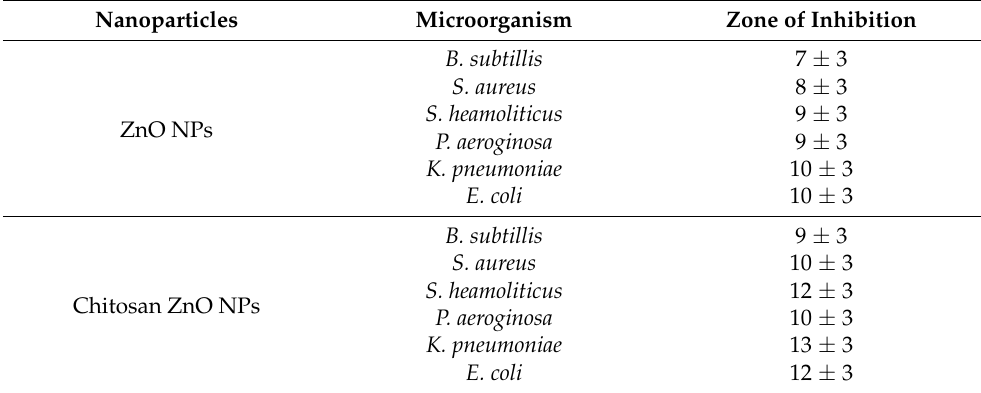
Table 3. Antibacterial activity exhibited by ZnO NPs, chitosan ZnO NPs against Gram-positive and Gram-negative bacterial